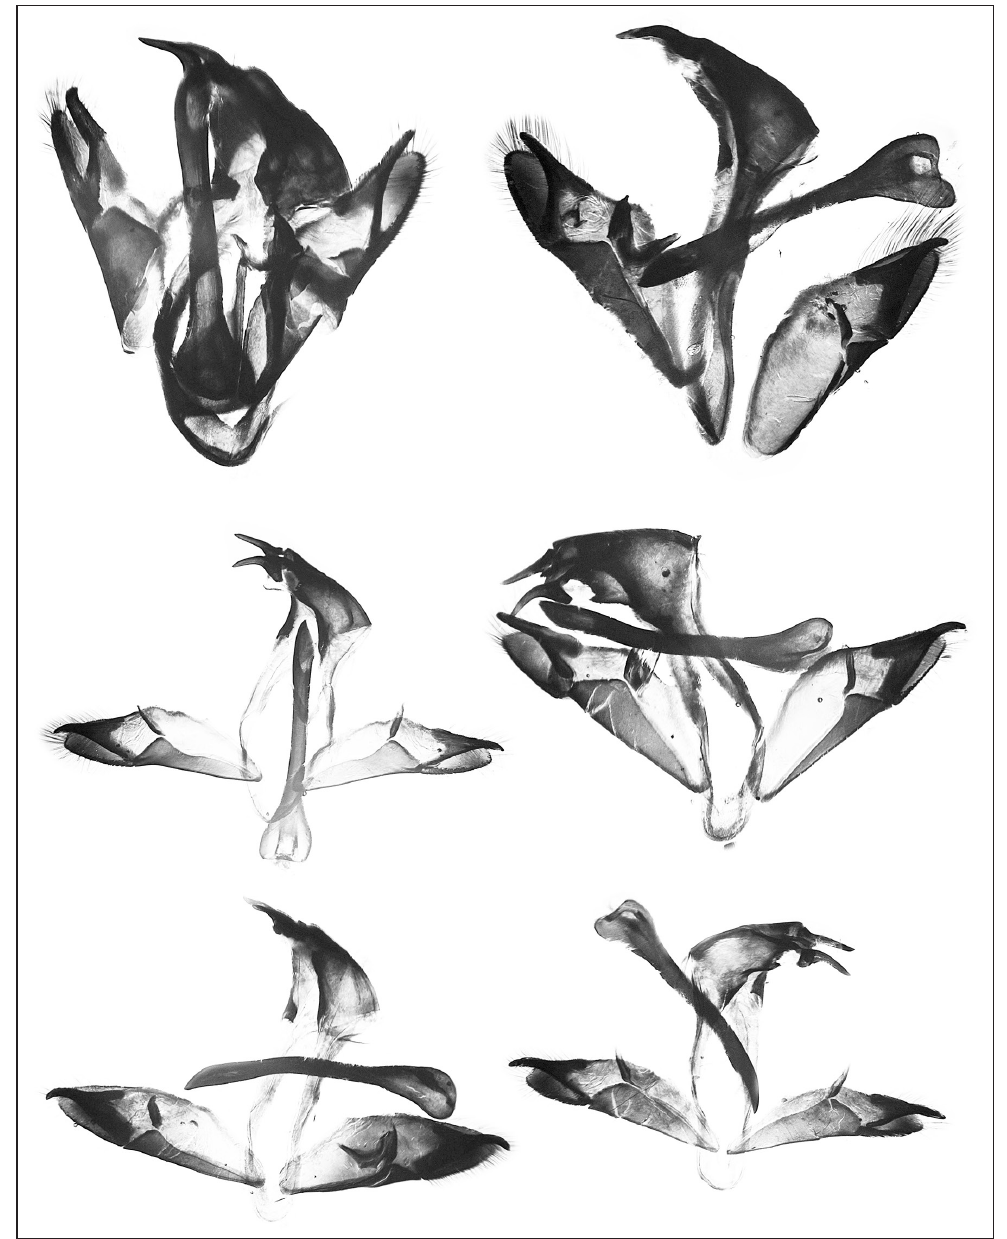
Figure 2. Male genitalia of Parnassius apollonius (Eversmann, 1847) from the same locality. Kirghizia, Suusamyr Valley, west shore of Karakol River, 2200–2500